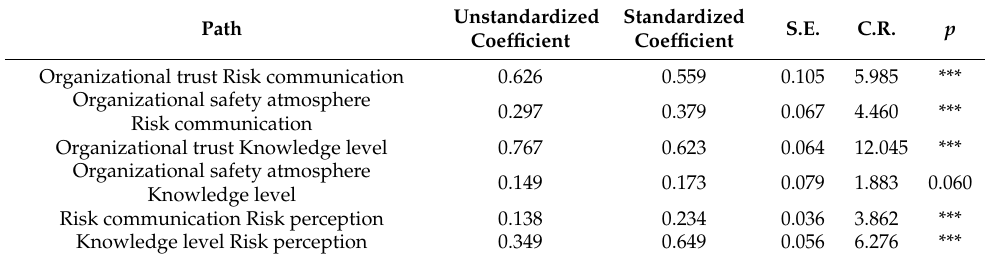
Table 6. Model 1 of path